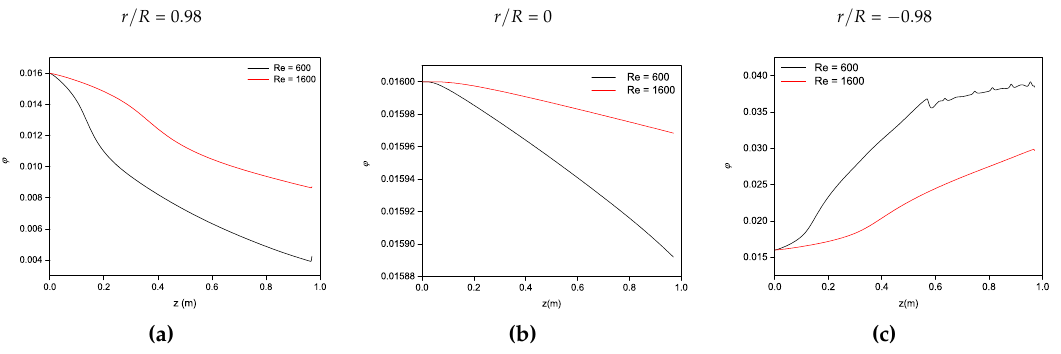
Figure 13. Axial variations of the volume fraction ϕ in Cu nanoparticles at three radial locations: ( a ) r / R = 0.98; ( b ) r / R = 0; and ( c ) r / R = − 0.98. Results obtained for Cu nanoparticles of diameter d np = 200 nm with ϕ = 0.016 and two Reynolds numbers Re = 600 and 1600.